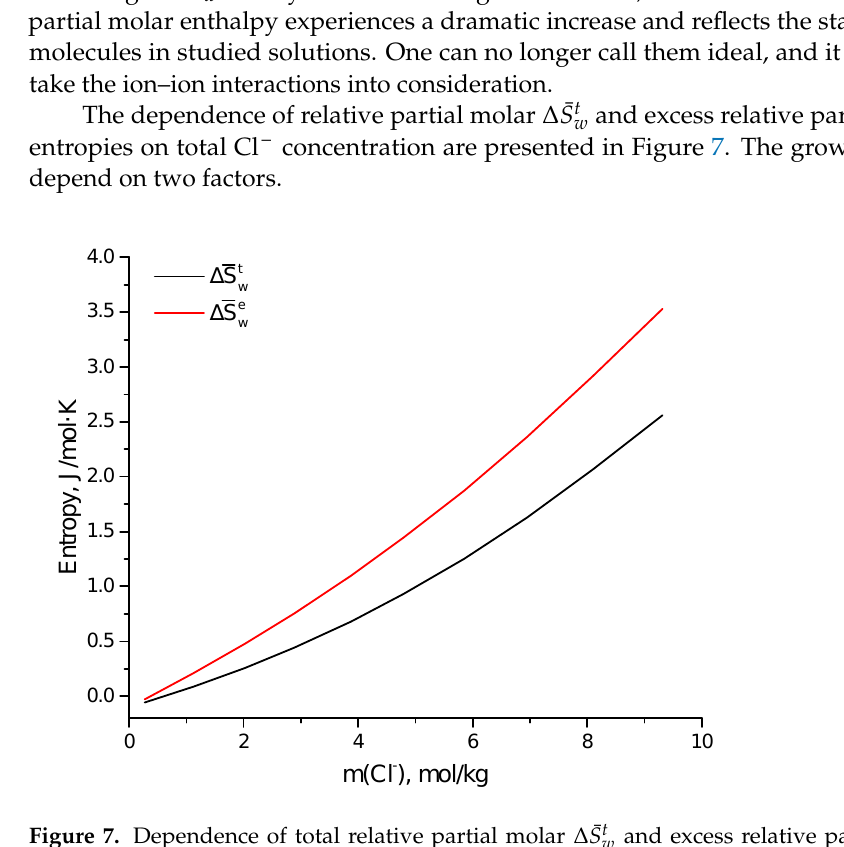
Figure 7. Dependence of total relative partial molar ∆ ¯ S t w and excess relative partial molar ∆ ¯ S e w entropies on total Cl –